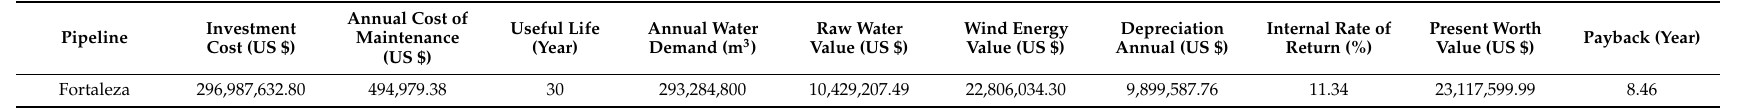
Table 18. Economic Simulation in hypothesis of systems coupled between raw water transport and wind power generation to Fortaleza.